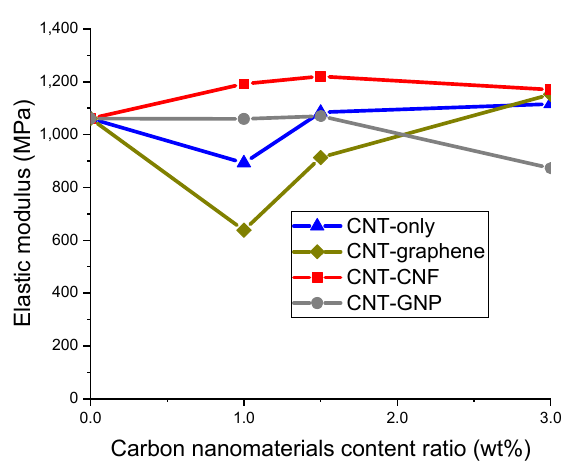
Figure 3. Elastic modulus of the epoxy-based composites incorporating CNT-only, CNT–graphene, CNT–CNF, or CNT–GNP, determined in tensile loading tests and plotted as a function of CNM content ratio.